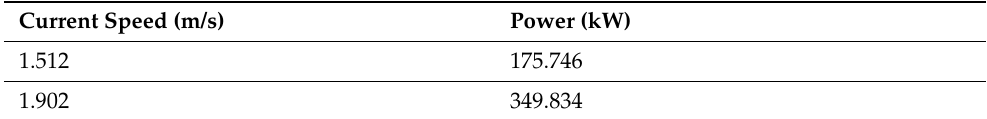
Table 5. Values of power according to current speed.